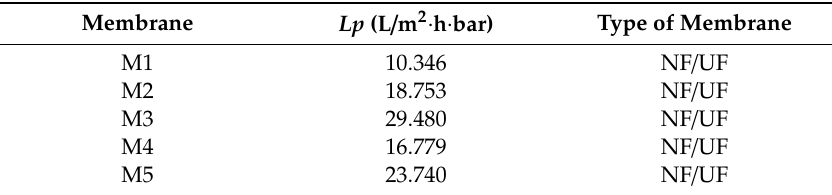
Table 3. Membrane permeability coe ffi cient ( Lp ).